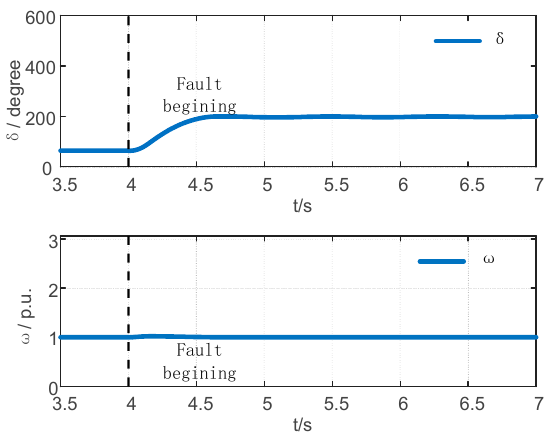
Figure 18. Power angle and speed of the generator with phase sequence exchanging system based on an MMC (magnified blue line in Figure 17).